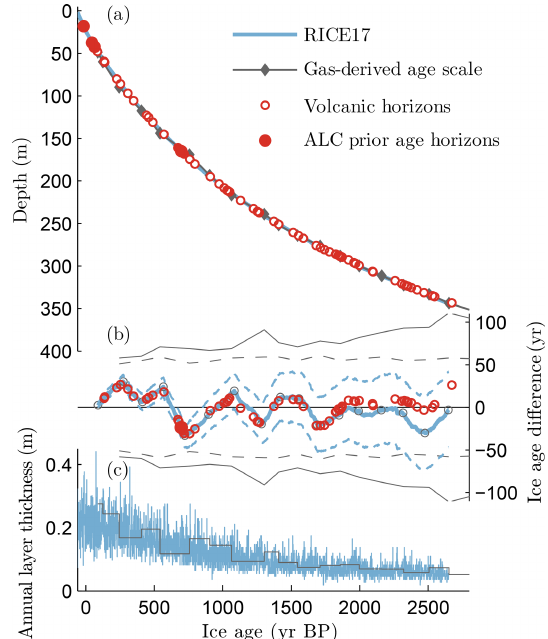
Figure 7. Comparison of the gas-derived (gray) and the annual- layer-counted ice age-scale (blue; Winstrup et al., 2019). Six abso- lute age markers (closed red circles) were identified, and an addi- tional 67 volcanic horizons were cross correlated to volcanic hori- zons in the WAIS Divide core (plotted on WD2014 ice age-scale, open red circles; Winstrup et al., 2019). (b) Difference in ice age between the gas-derived ice age-scale and annual layer counts; pos- itive values indicate that at the same depth the annual layer counts are older than in the gas-derived age-scale. Uncertainty estimates of the gas-derived ice age-scale (solid gray lines), the (cid:49) age esti- mate only (dashed gray lines), and the annual-layer-counted age- scale (blue dashed lines). (c) Interpretations of annual layer thick- ness from the gas-derived ice age-scale and annual layer interpreta-